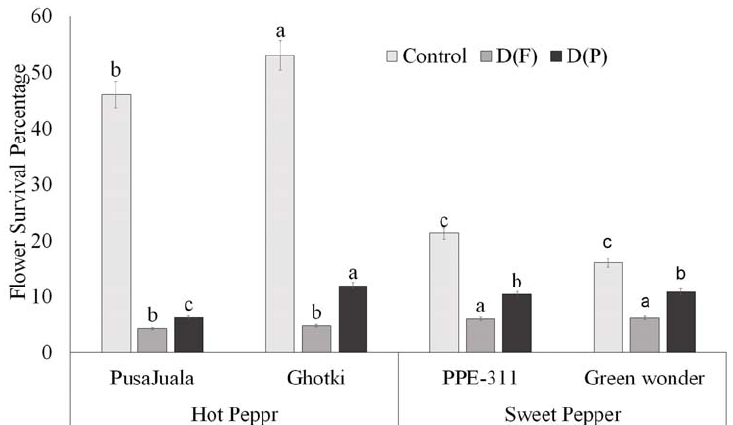
Figure 3. Flower survival percentage. Means of three repetitions for each genotype with the same letters indicate the same means, and different letters indicate significant differences. Vertical bars represent the standard error of means (bars = ±se). Bars without letters represent non ‐ significant means (LSD p < 0.05). DF = water stress at the flowering stage, DP = water stress at the pod formation stage.